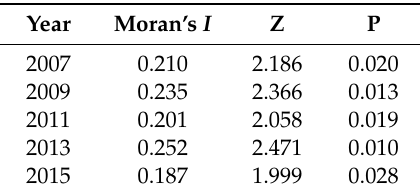
Table 3. Spatial autocorrelation test.